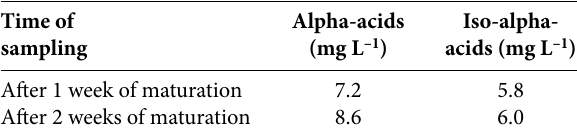
Table 3. Dynamics of isomerization in beer D